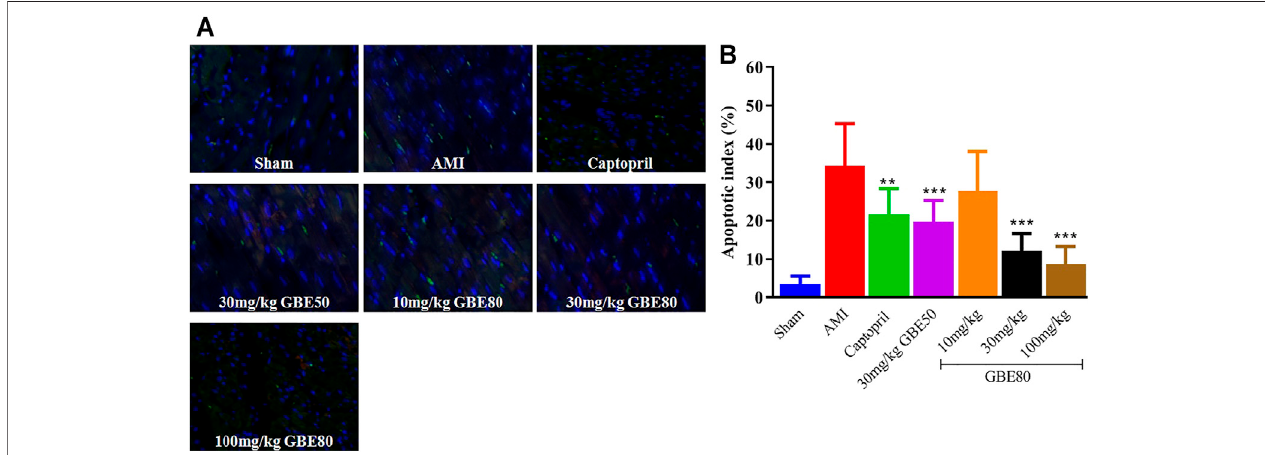
FIGURE 4 | GBE80 inhibits cardiomyocyte apoptosis of the left ventricle in AMI. (A) Representative fi gures of TUNEL-stained myocardial tissues of acute myocardial infarction (AMI) rats receiving the indicated treatment ( × 200). (B) Quantitative statistical analysis of cardiomyocyte apoptosis. (**, *** indicates p < 0.01, p < 0.001 vs the AMI group, respectively).